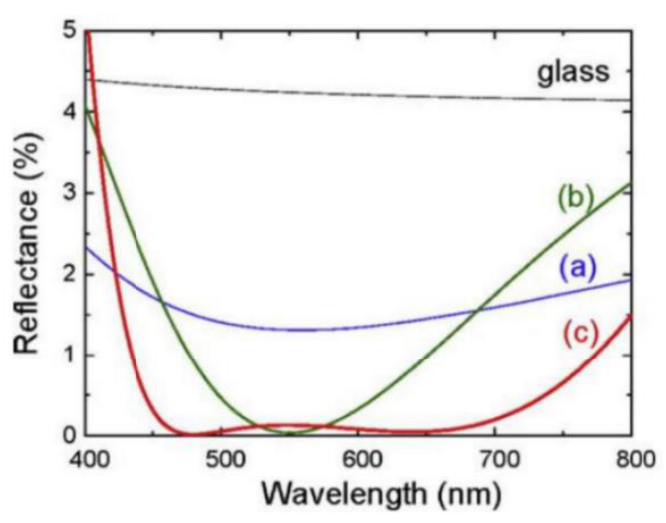
Figure 2. Reflectance curves of (a) SLARC, (b) DLARC, and (c) TLARC. Reprinted with permission 2010, [8]; 2010, Elsevier.